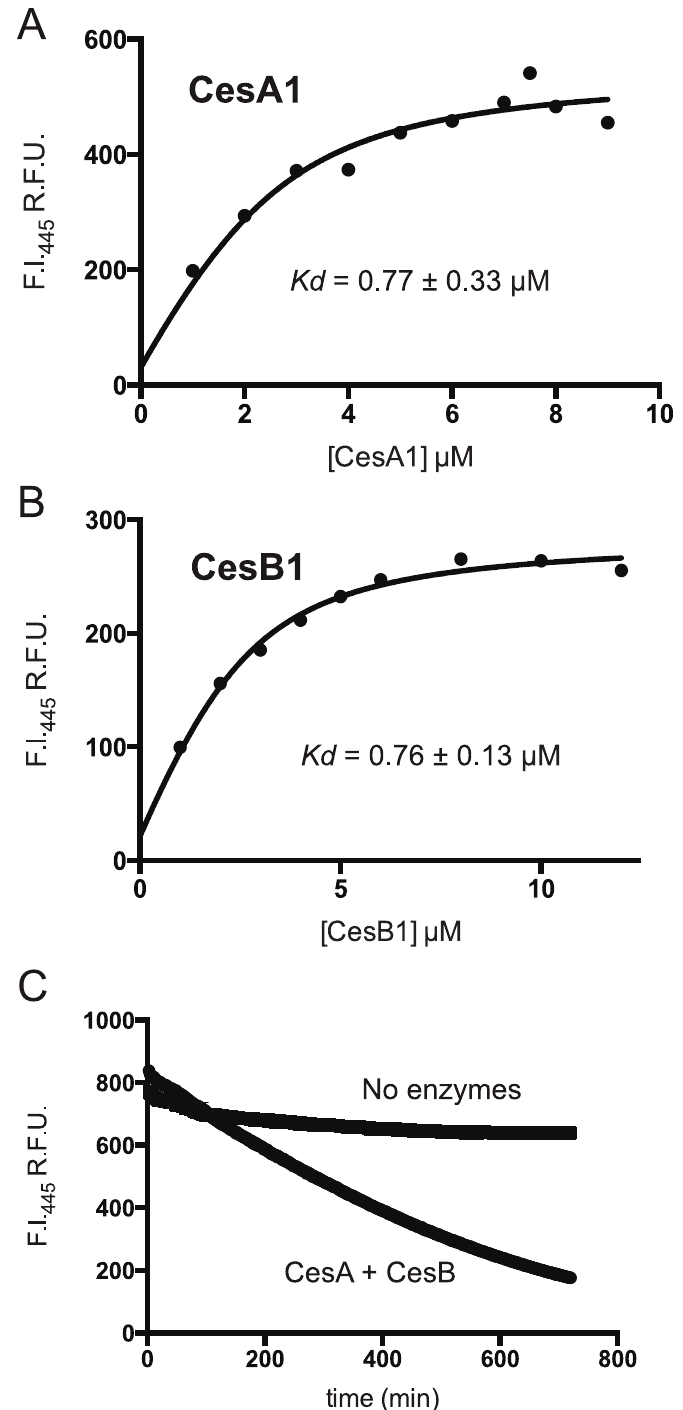
Fig 7. NADPH affinity and turnover in the KR domains in CesA1 and CesB1. (A,B) Fluorescence intensity enhancement is plotted against protein concentration using a fixed concentration of NADPH (2.5 μ M); λ exc = 340nm and λ emm = 445nm for CesA1 and CesB1. Curves were fitted to a Morrison equation that includes terms for enhancement of NADPH fluorescence upon binding. (C) Enzymatic NADPH consumption as reported by fluorescence intensity ( λ exc = 340nm and λ emm =